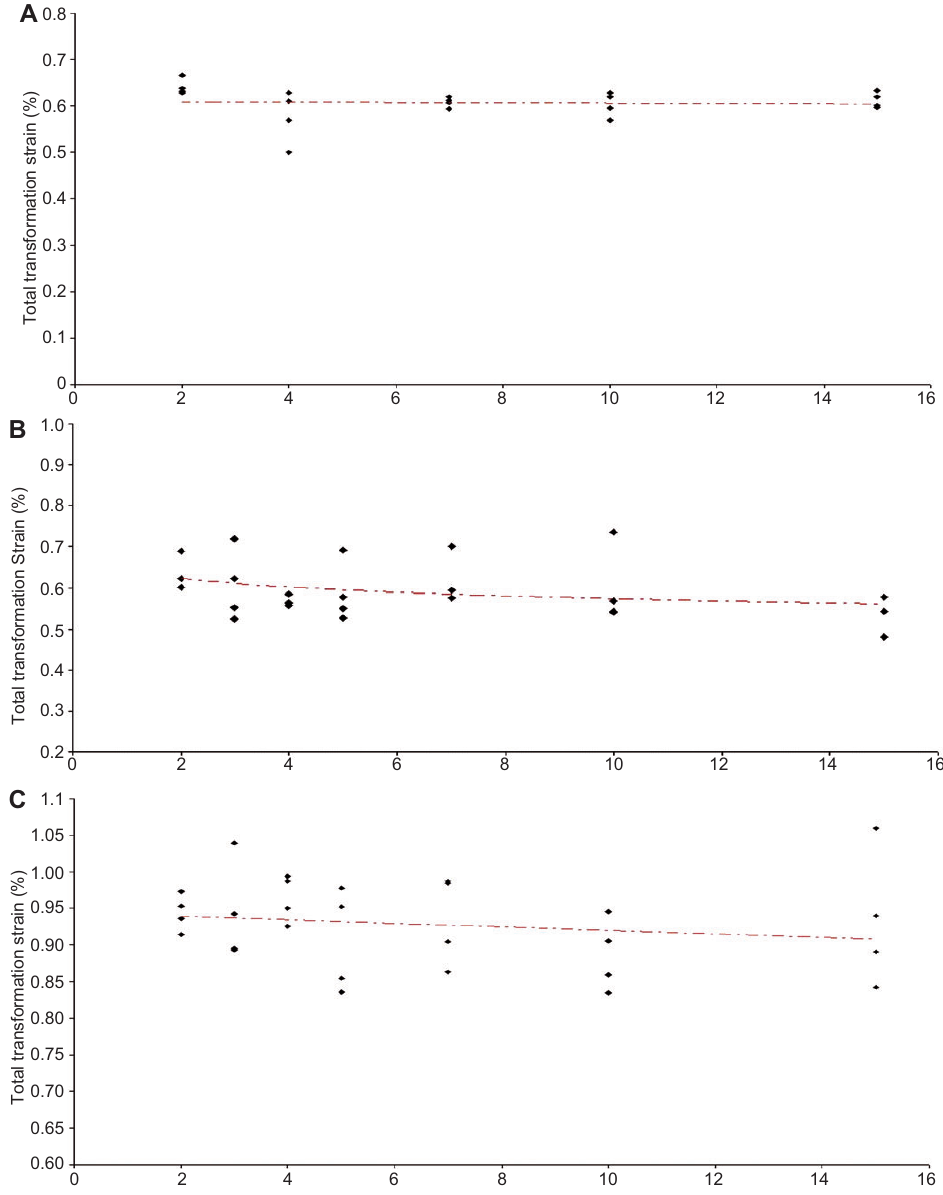
Figure 7 Effect of displacement rate on the total transformation strain for (A) 1 mm, (B) 2 mm and (c) 3 mm diameter